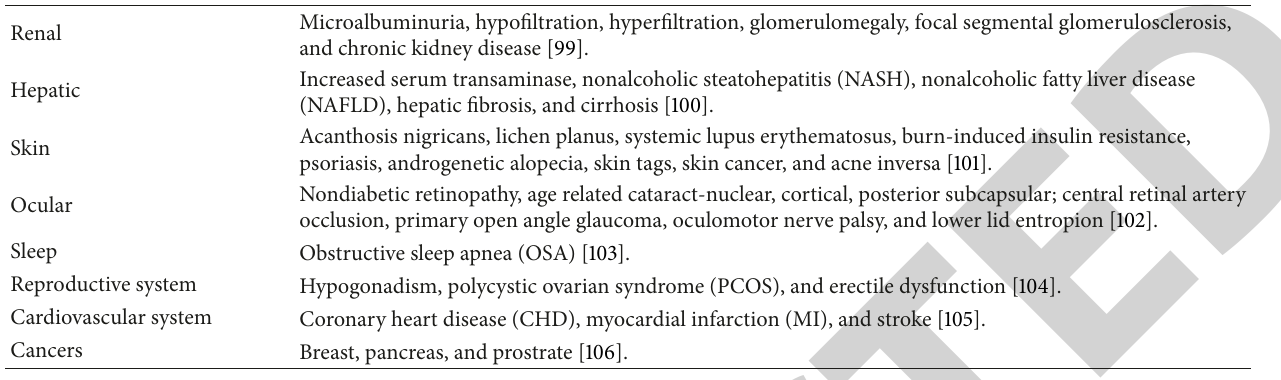
Table 3: Systemic effects of